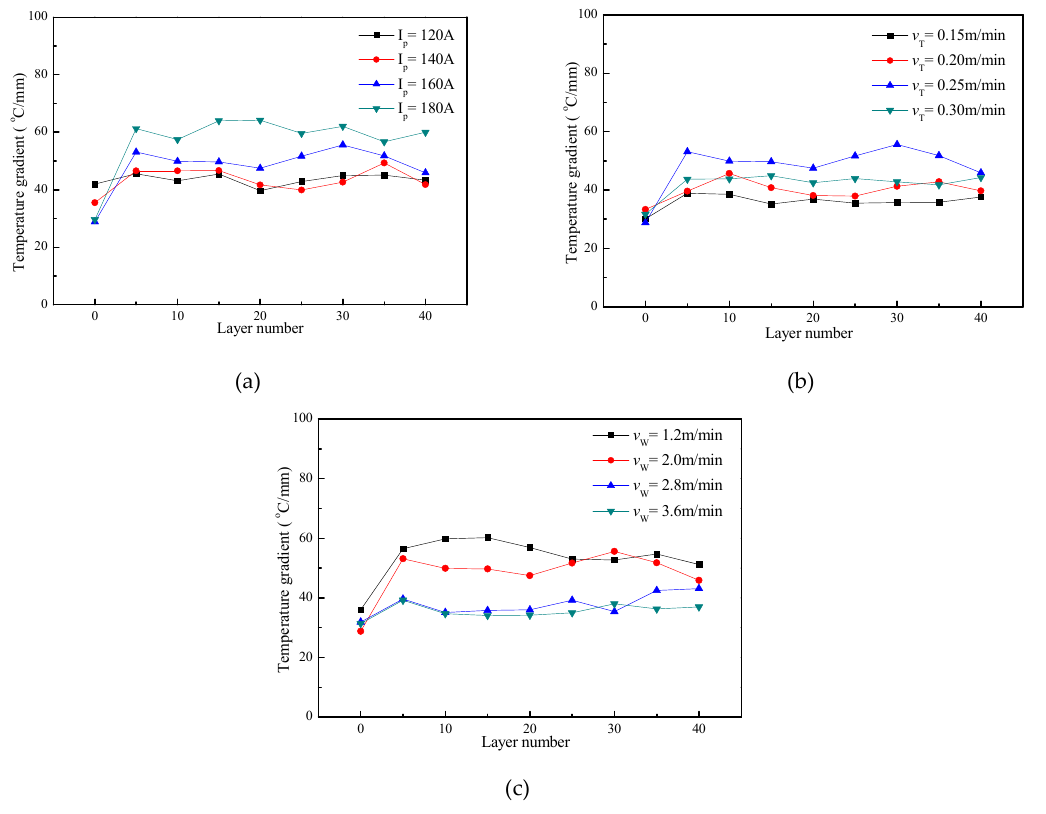
Figure 9. Temperature gradient variation with layer numbers under different ( a ) peak currents, ( b ) travel speeds and ( c ) wire feed speeds.